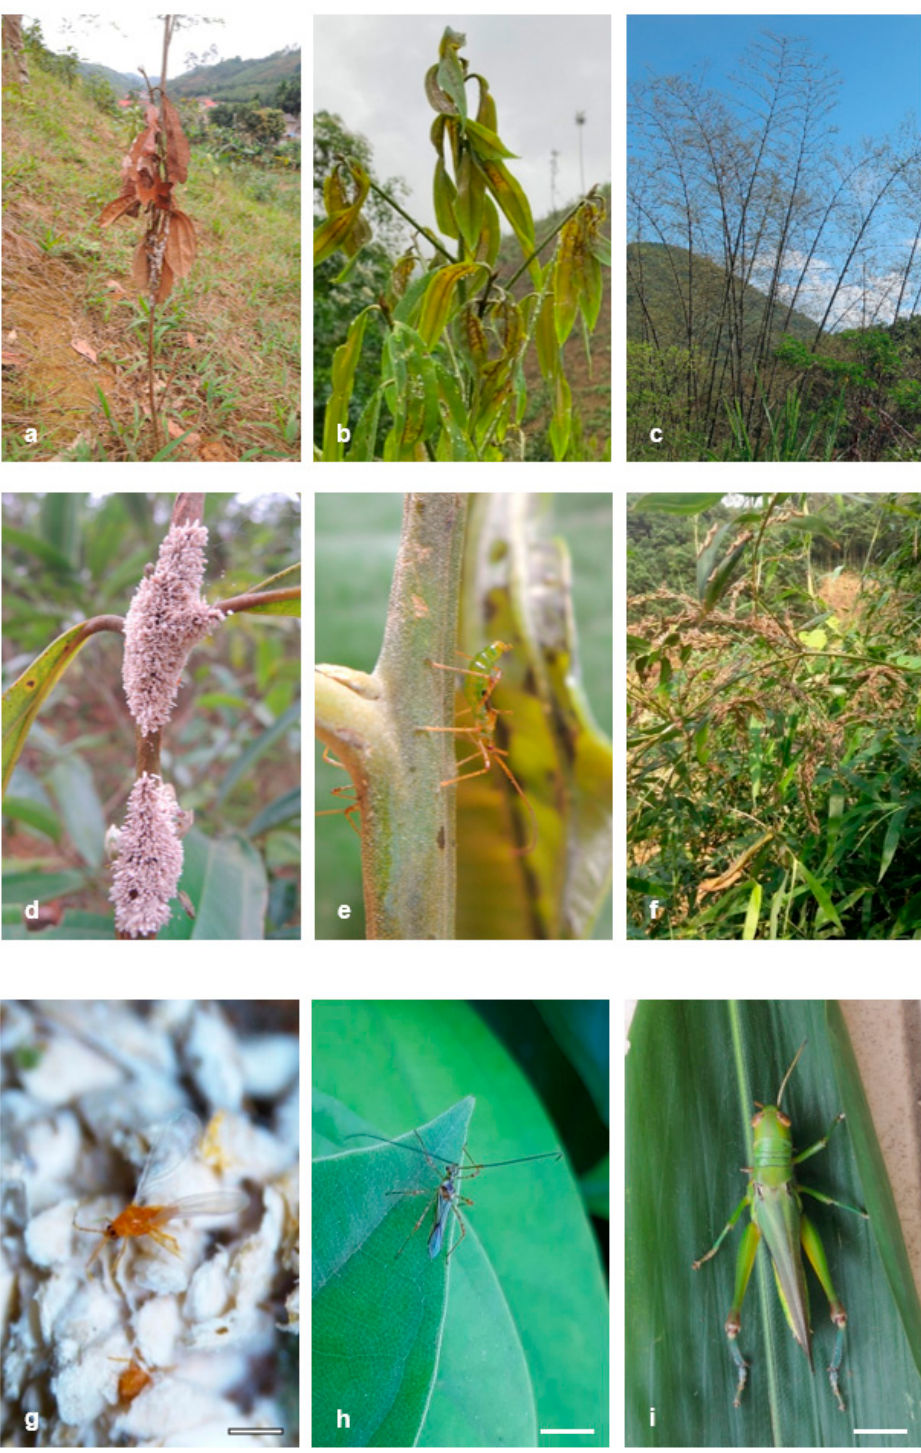
Figure 5. Sap-sucking insect damage to forest plantations in Vietnam. ( a – c ) damaged trees and bamboo; ( d – f ) larvae; ( g – i ) adults. ( a , d , g ) Aulacaspis tubercularis damage in Cinnamomum cassia ; ( b , e , h ) Helopeltis theivora damage in C. cassia ; ( c , f , i ) Hieroglyphus tonkinensis damage in Dendrocalamus barbatus . Scare bar: g = 0.2 cm; h = 0.5 cm; i = 1.0 cm. It has now spread to C. cassia plantations in two further regions. The sap-sucking scale poses a severe threat to nursery stock and 1–5-year-old plantations (Figure 5a,d). p % and DI are 9–31% and 0.1–1.0 in nurseries, and 15–41% and 0.2–1.3 in plantations,